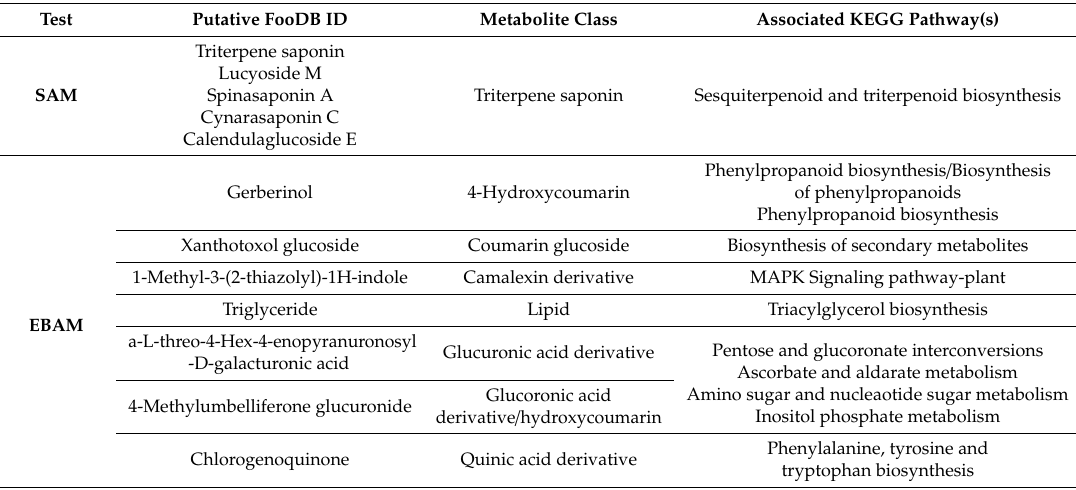
Table 5. Results of significance analysis of microarrays (SAM) and empirical Bayes analysis of microarrays (EBAM) analysis results for African violet cultures treatment with 0 vs. 2 µ M thidiazuron (low TDZ), 0 vs. 20 µ M thidiazuron (high TDZ) yielded no significant results and is not